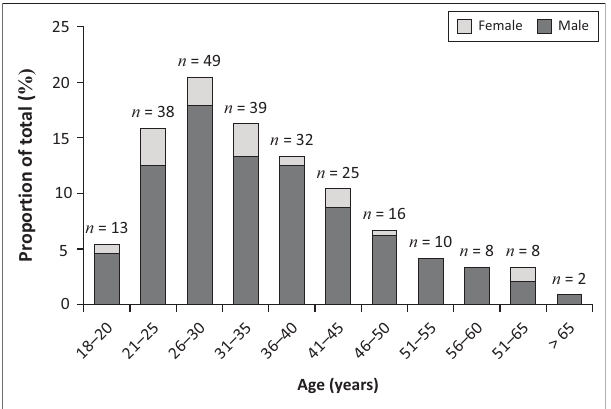
FIGURE 1: Frequency and distribution of ocular trauma ( n = 240) according to age and sex.